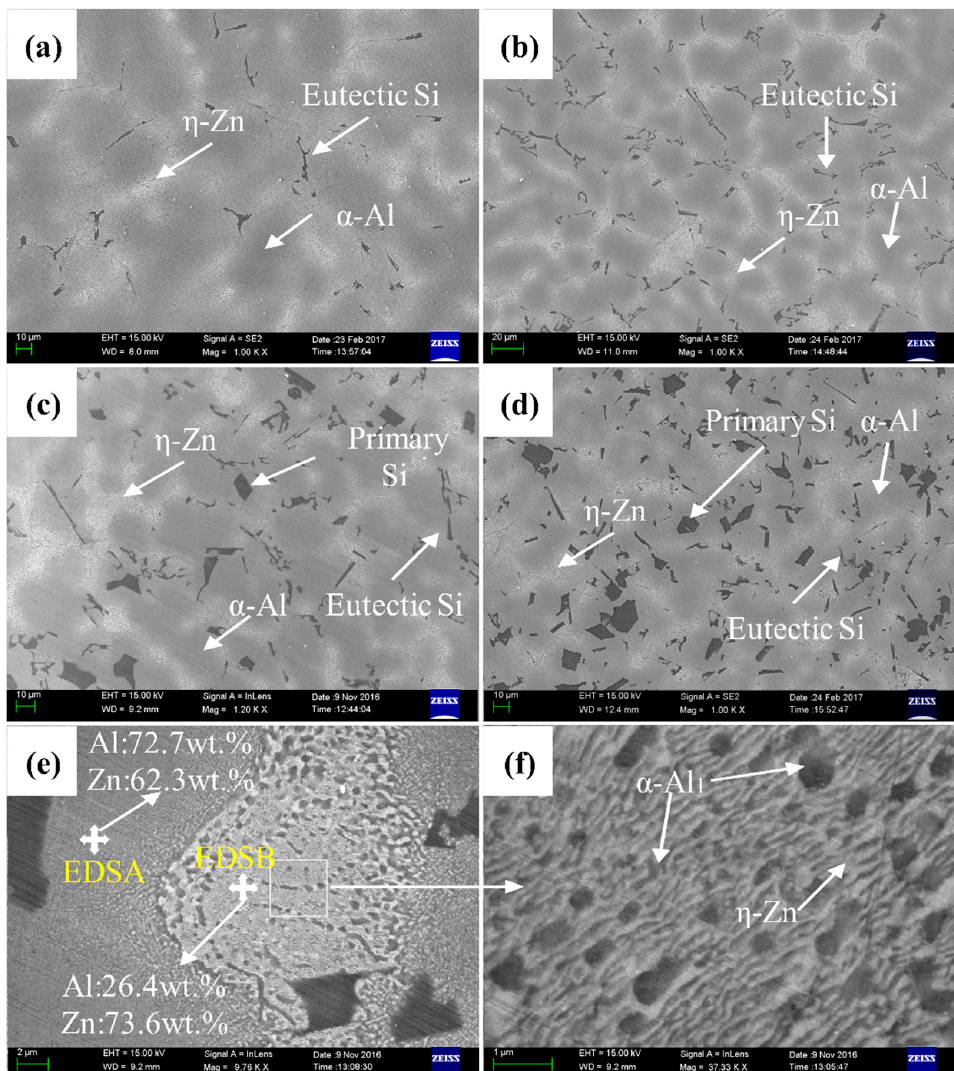
Figure 4. Microstructure of Al-40Zn-xSi alloy: ( a ) Al-40Zn-1Si, ( b ) Al-40Zn-3Si, ( c ) Al-40Zn-5Si, ( d ) Al-40Zn-6Si, ( e , f ) ternary eutectic microstructure of Al-40Zn-5Si